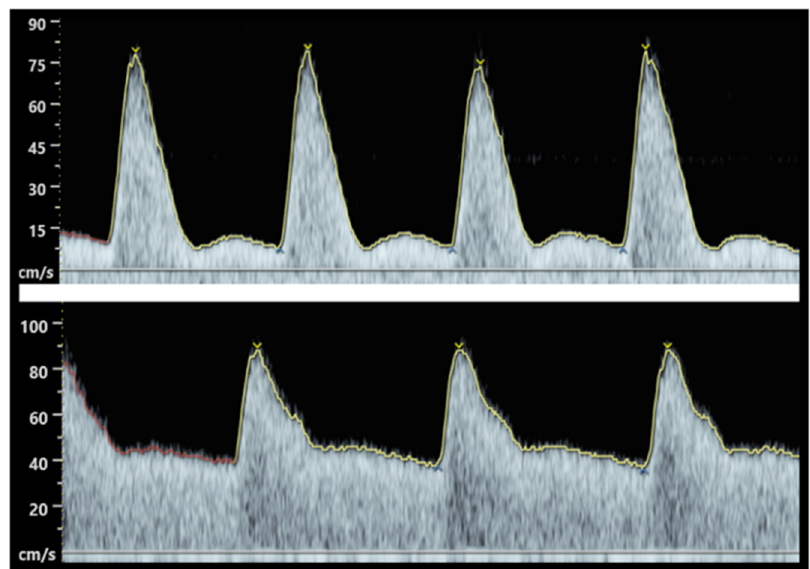
Figure 1. Abnormal ( top ) and normal ( bottom ) uterine artery Doppler waveform in the first trimester. While systolic velocities are similar, the lower waveform show a low resistance vessel with broader systolic peak, as well as a continuous diastolic flow, secondary to a complete remodelling of the spiral arteries. In contrast, the abnormal waveform ( up ) shows an artery with high resistance, as well as a sharp systolic peak, a flow reduction at the start of diastole (“notch”), and low diastolic velocities with poor blood flow.